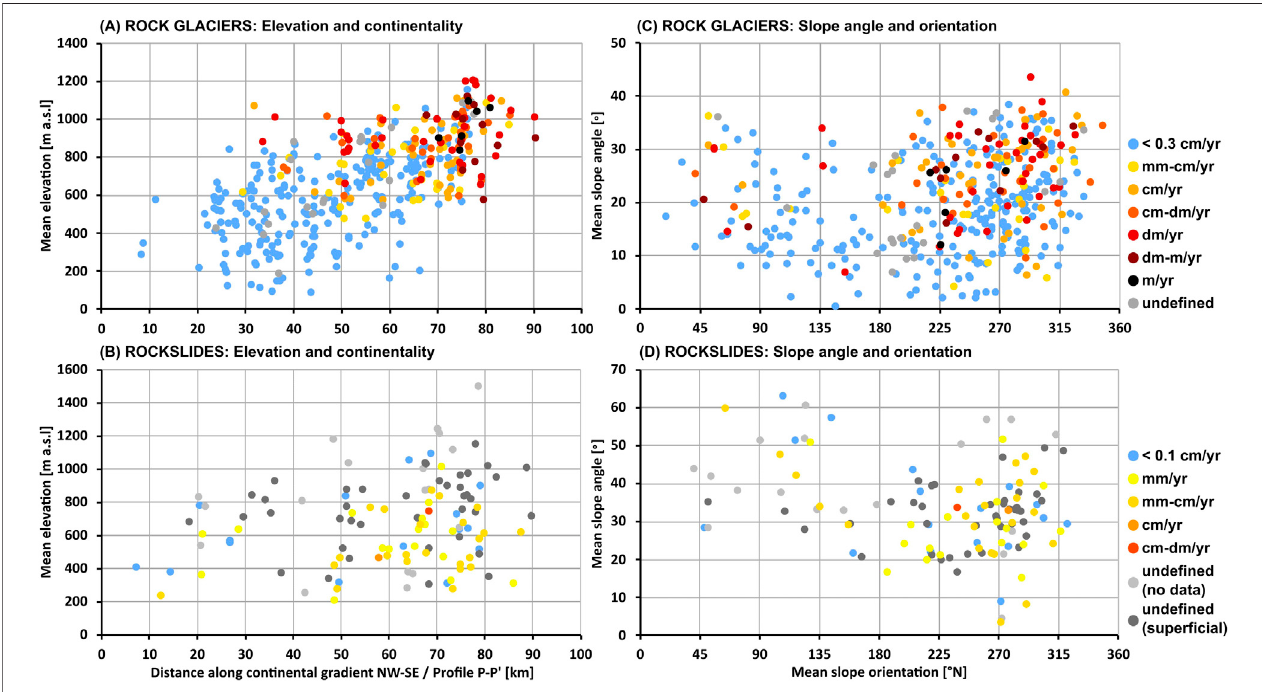
FIGURE12| Rockglacier(RG)androckslide(RS)distributionandtopo-climaticfactors.Left:Relationbetweenkinematicattribute,meanelevationandcontinentalityfor theinventoried RG (A) andRS (B) .X-axis:DistancealongNW – SEcontinentalgradient(landformsprojectedalongpro fi leP – P ’ , Figure1 ).Right:Relationbetweenkinematic attribute, slope angle and slope orientation for the inventoried RG (C) and RS (D) . Mean elevation, slope angle and orientation are based on a 10 m DEM (NMA, 2016).